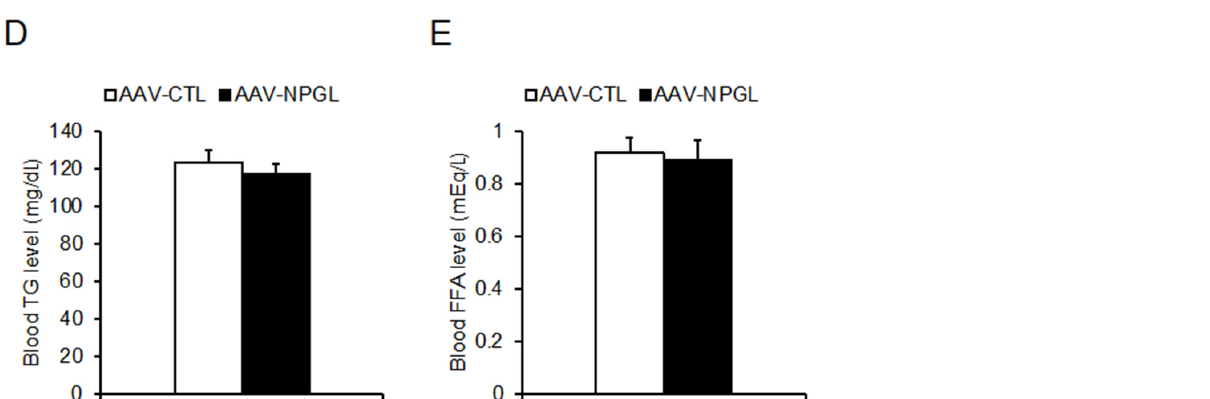
Figure 5. Effects of Npgl overexpression on blood biomarkers in mice fed a high-fat diet with 60% calories from fat. These mice were 26 weeks old at 18 weeks after injection of an adeno-associated virus (AAV) vector, either a control (AAV-CTL) or a vector carrying the NPGL precursor gene (AAV-NPGL). ( A – E ) Levels of blood glucose ( A ), insulin ( B ), leptin ( C ), triglycerides (TG) ( D ), and free fatty acids (FFA) ( E ). All statistical analyses were performed using Student’s t -test. Each value represents the mean ± standard error of the mean (AAV-CTL: n = 8, AAV-NPGL: n = 8; * p < 0.05).